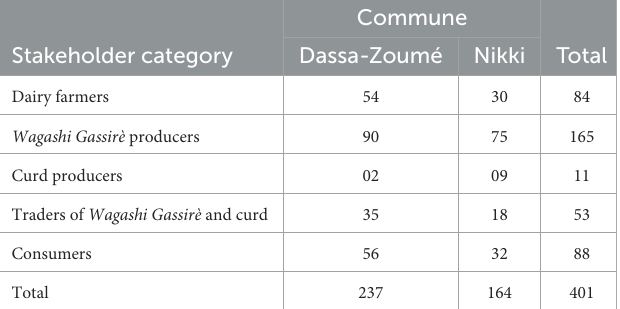
TABLE 1 Distribution of respondents according to stakeholder category in each